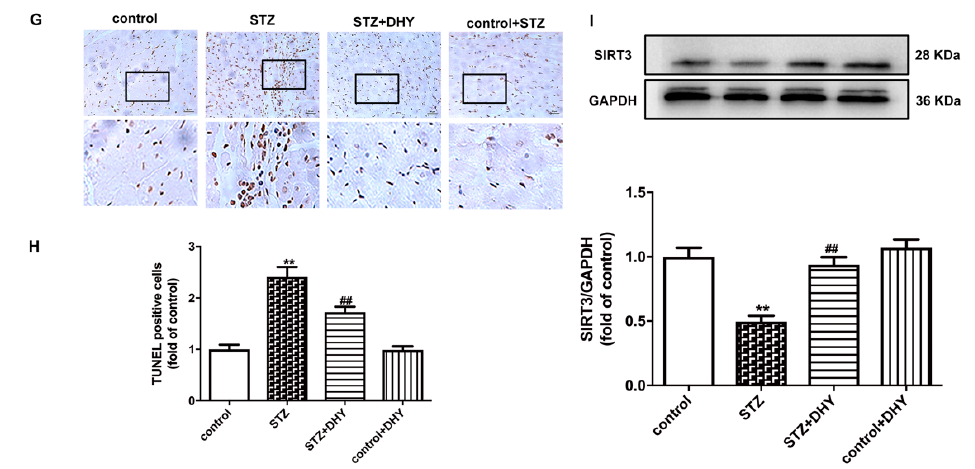
Figure 4. DHY suppressed oxidative stress, inflammasome and necroptosis but improved SIRT3 expression in STZ-induced C57BL/6 mice. ( A ) The representative images of myocardium with DHE staining (red) and nuclei with DAPI staining (blue) (bar = 50 µ m). ( B ) The representative images of myocardium with MitoSOX staining (red), mitochondria localization with Mito-tracker staining (green) and nuclei with DAPI staining (blue) (bar = 50 µ m). ( C – F ) Expression of IL-1 β , NLRP3, RIPK3 and MLKL protein in the myocardium. ( G , H ) The representative images of myocardium with TUNEL staining (bar = 20 µ m). TUNEL positive cells were quantified. ( I ) Expression of SIRT3 protein in the myocardium. ** p < 0.01 versus control; # p < 0.05, ## p < 0.01, versus STZ, n =